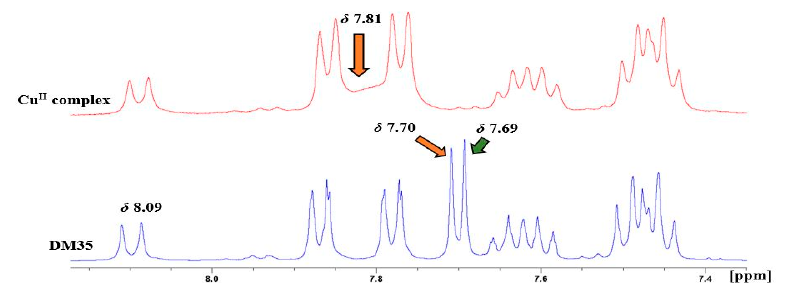
Figure 6. The 1 H NMR spectra of DM35 and its Cu II complex with CuSO 4 ∙ 5H 2 O in d 6 -DMSO. The 1 H NMR spectra of the copper complex with DM35 were also evaluated at different temperatures, from 30 to 60 ◦ C (Figure 7, Figures S24 and S25), the triazole signals showed upfield shift to a broad signal, but more defined peak at around 7.71 ppm, this is close to the chemical shifts of macrocycle without Cu (II), which indicates that the Cu (II) is more dissociated from the binding to the two triazole nitrogen atoms at elevated temperatures. The anomeric proton appeared broad singlet at 30 ◦ C, at 4.79 ppm, and shifted to 4.81 to a doublet (Figure S24a). The amide NH signal shifted upfield at higher temperature indicates that amide participates in intermolecular hydrogen bonding. The process is reversible as when the same NMR sample was cooled from 60 to 30 ◦ C (Figure S25), the signals for triazoles and amide reverted to the original